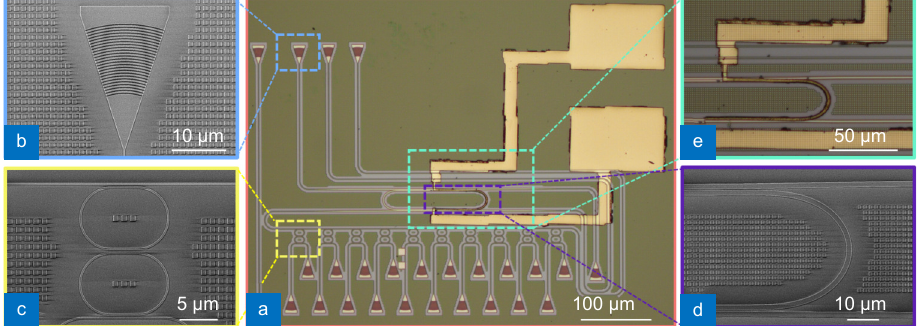
Fig. 2 | ( a ) Microscope images of the fabricated ultrahigh-resolution spectrometer. Zoom-in views of the grating coupler ( b ), the wideband reson- ator ( c ), the Euler bend ( d ), and the heater on ultra-high-Q resonator ( e